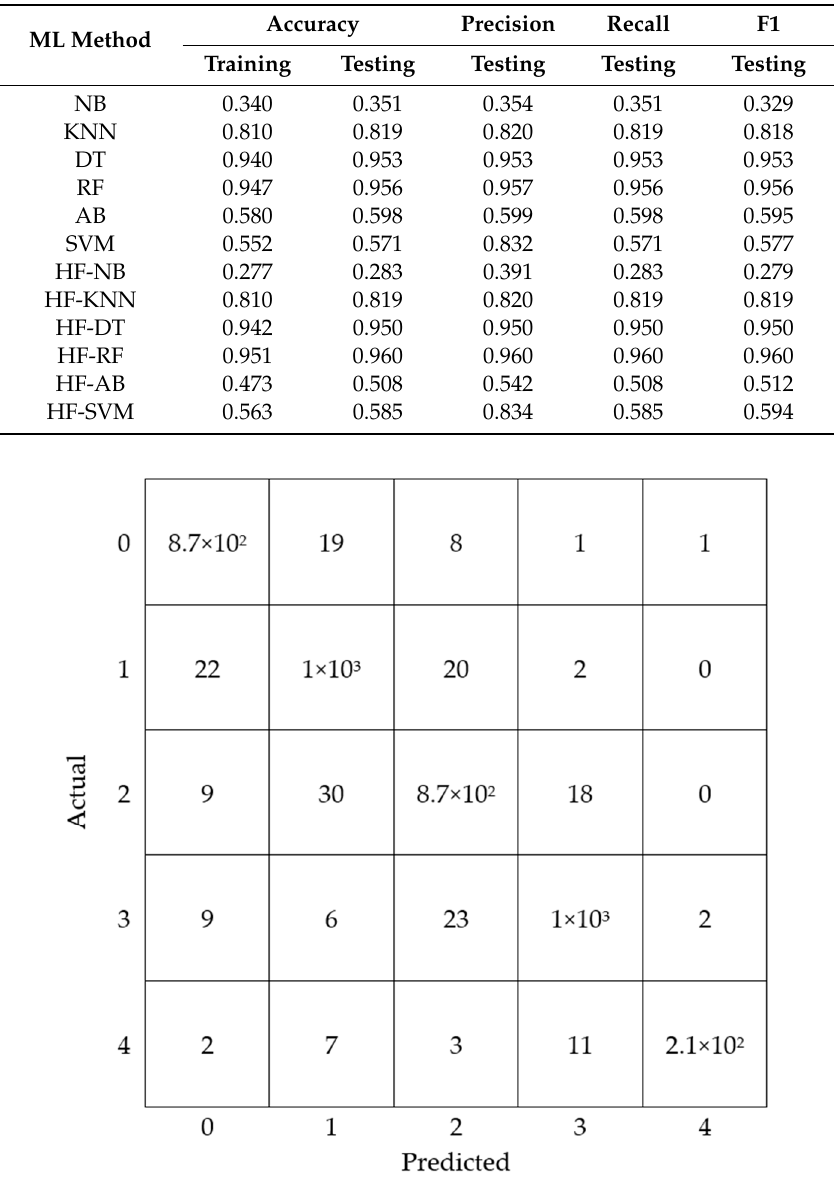
Figure 6. Confusion matrix of RF floor classification.